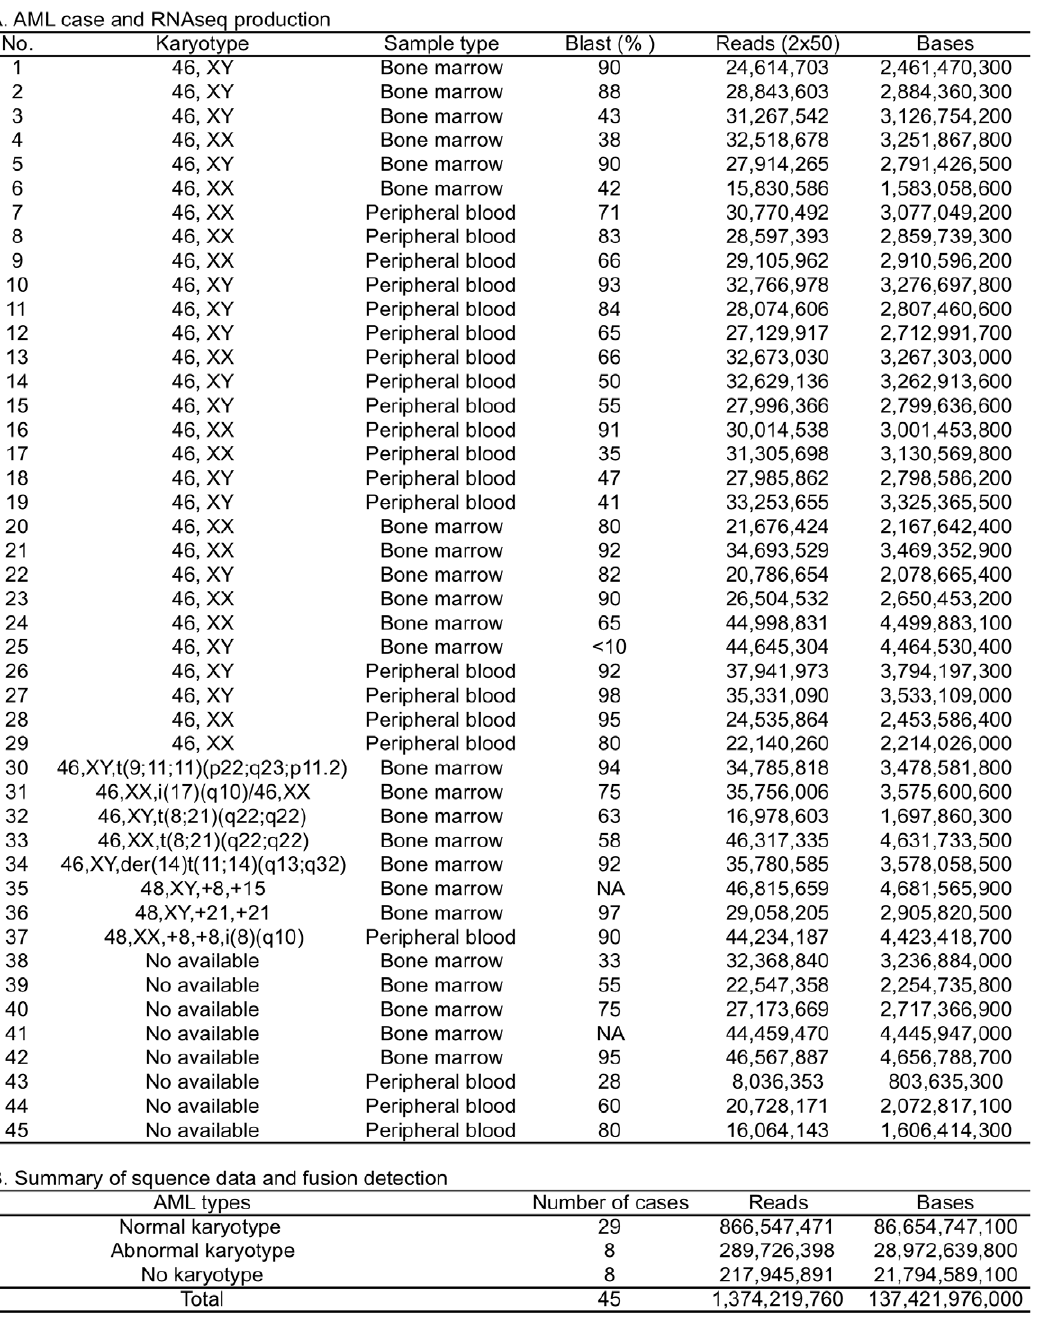
Figure 1. AML sample list and RNAseq data collection. A. A total of 45 AML samples were used for the analysis, including 29 normal karyotype AML, 8 abnormal karyotype AML and 8 AML without karyotype information. B. RNAseq data collected from the 45 AML